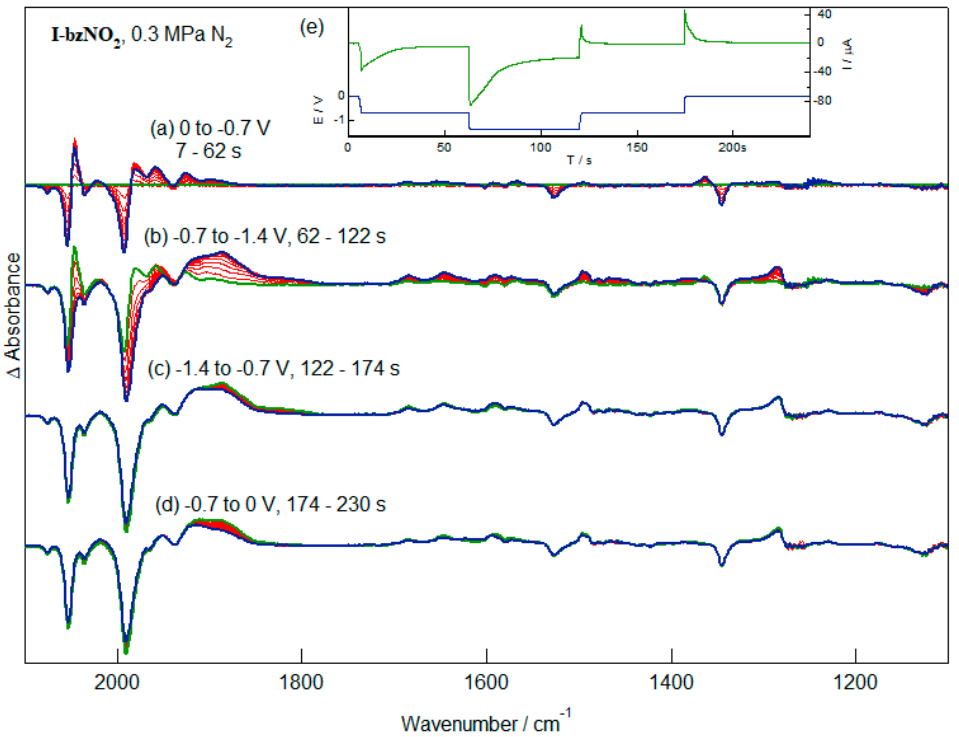
Figure 6. IR-SEC measurements of the first (a) and second (b) reduction processes of I-bzNO 2 followed by reoxidation at mild (c) and more forcing (d) conditions. The applied potential and current response of the cell during the IR-SEC experiment is shown in